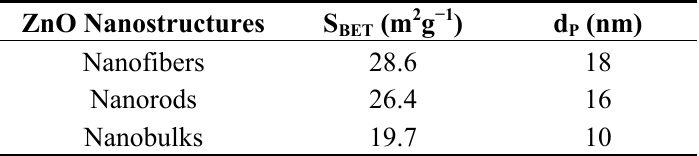
Table 1. BET surface area and pore structure parameters of the